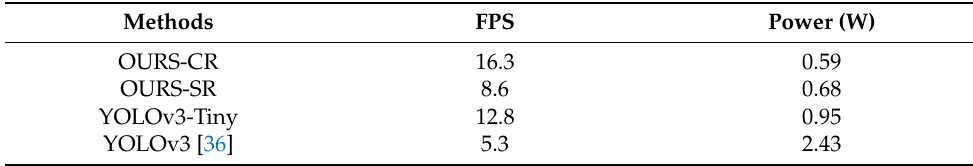
Table 5. FPS and power of different methods 1